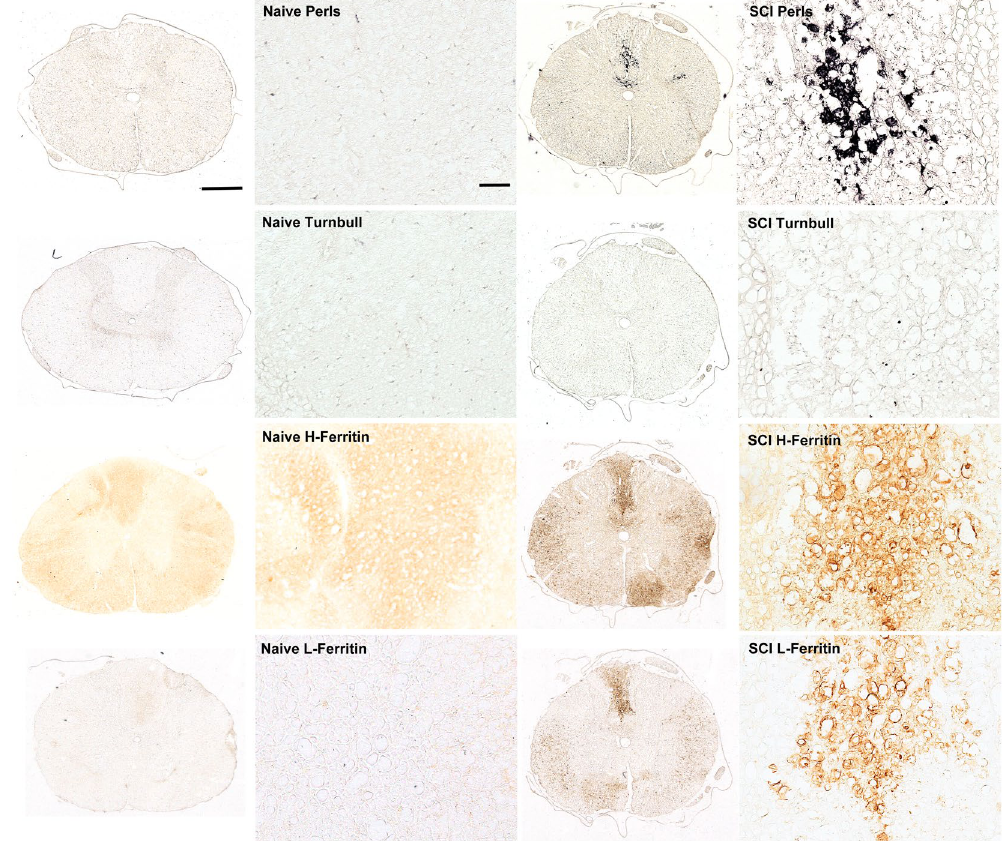
Figure 1. Biochemical analysis of spinal cord tissue shows Fe 3 + (Perls) staining in injured (SCI) rats. No significant staining was observed for Fe 2 + (Turnbull) in either naïve or SCI spinal cords. Immuno-histochemical (IHC) staining shows a basal expression of H-ferritin in naïve spinal cord but an increased expression of H and L-ferritin in SCI spinal cord in localized regions. Scale bars: 500 μ m and 100 μ m